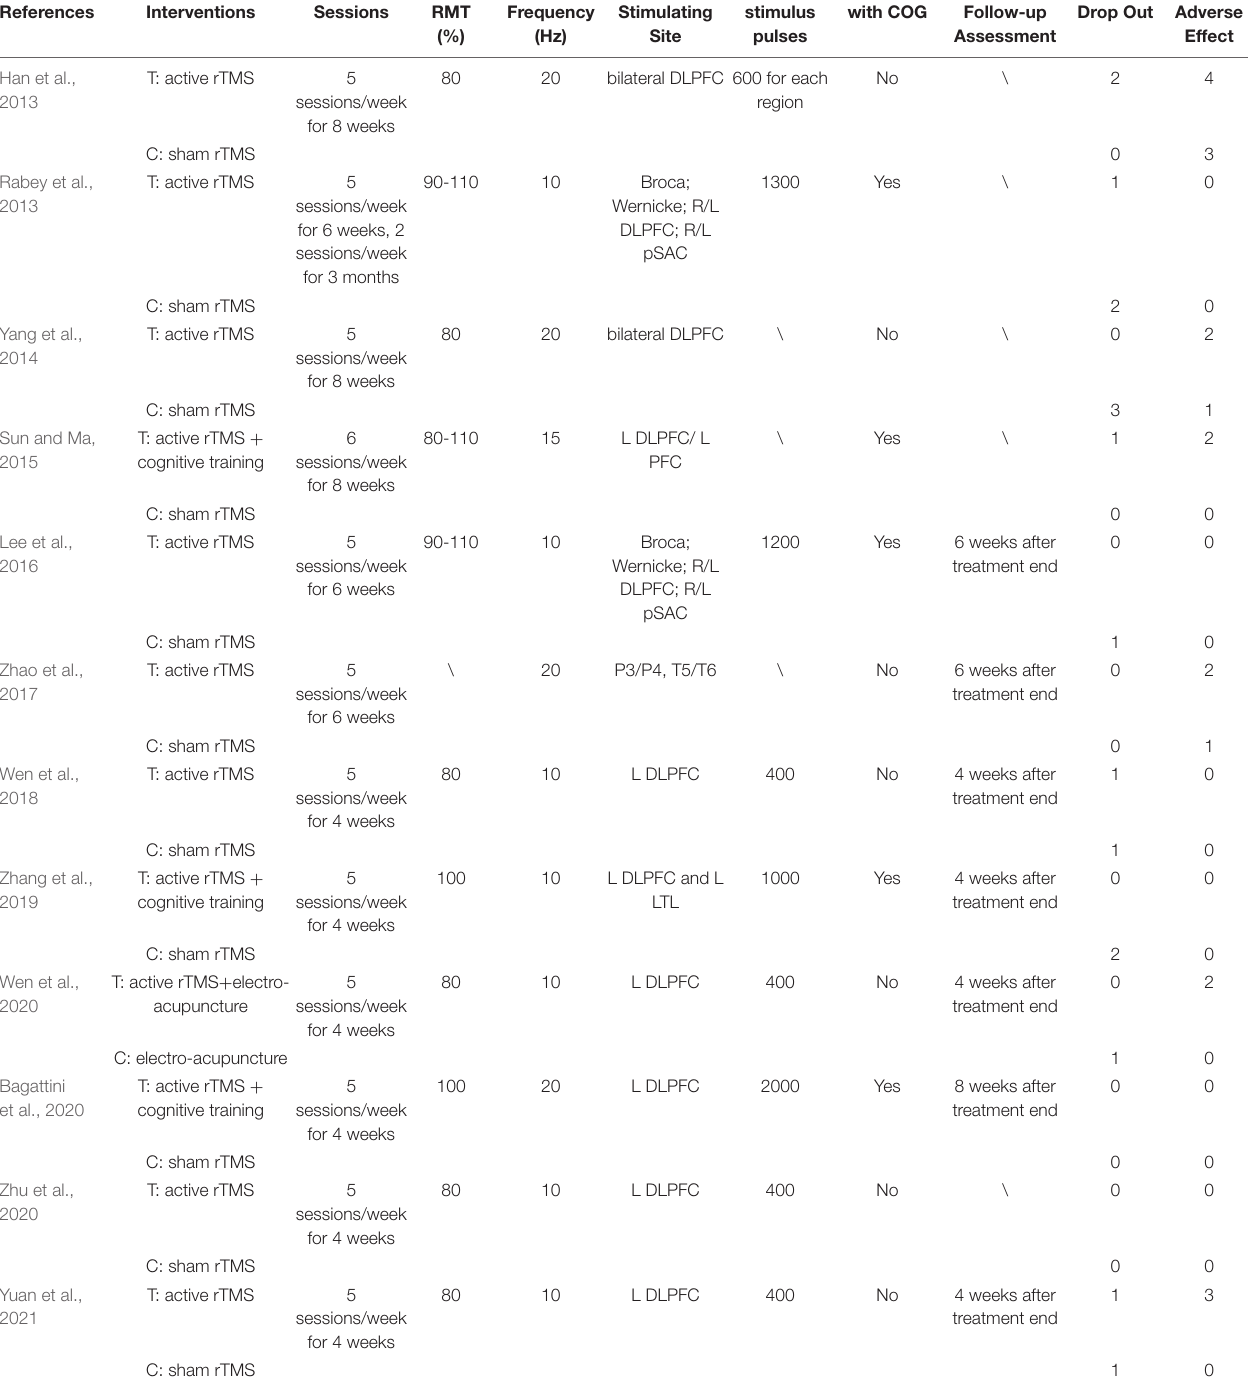
TABLE 2 | Description of rTMS intervention in the included